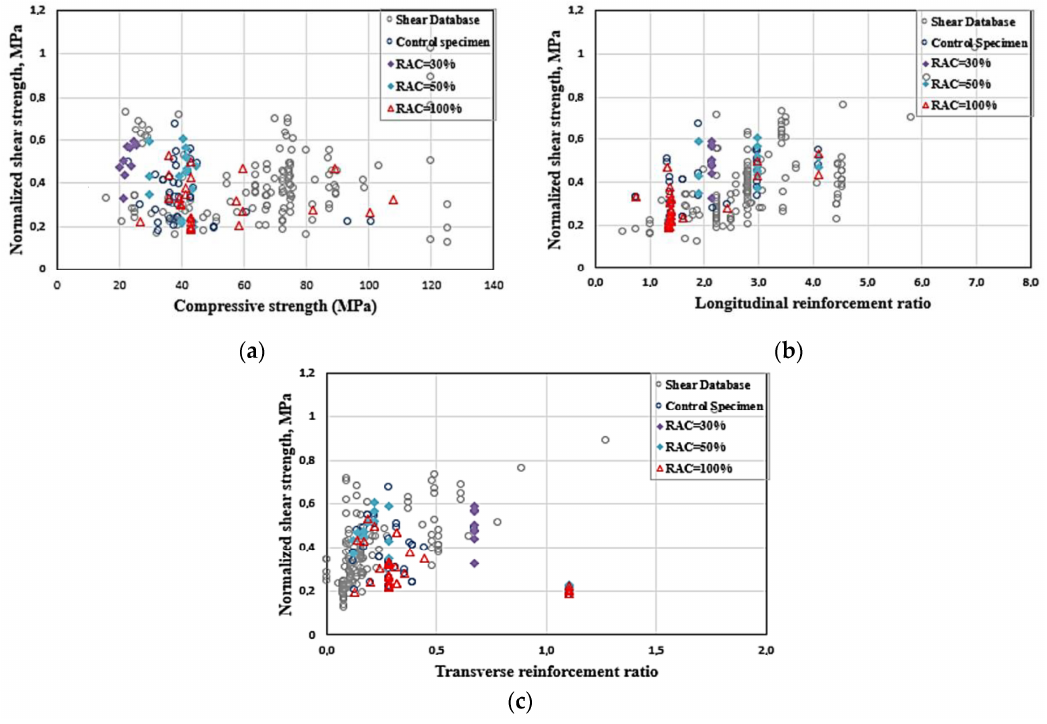
Figure 6. Shear test results of RCA and NCA reinforced concrete beams: ( a ) effect of compressive strength; ( b ) effect of longitudinal reinforcement; ( c ) effect of transverse